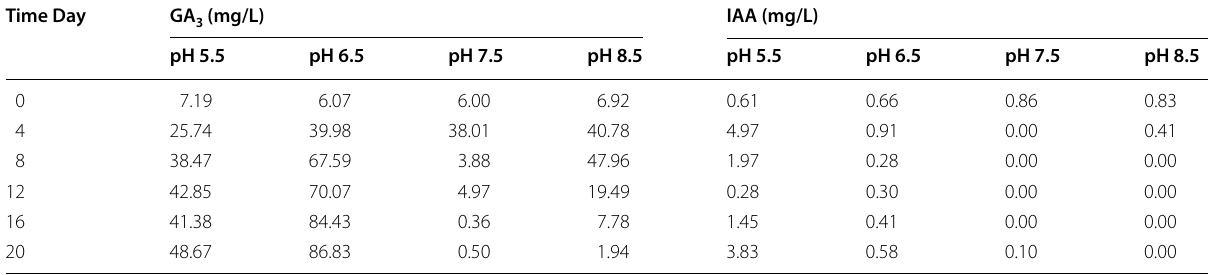
and IAA during the four anaerobic digestions 3